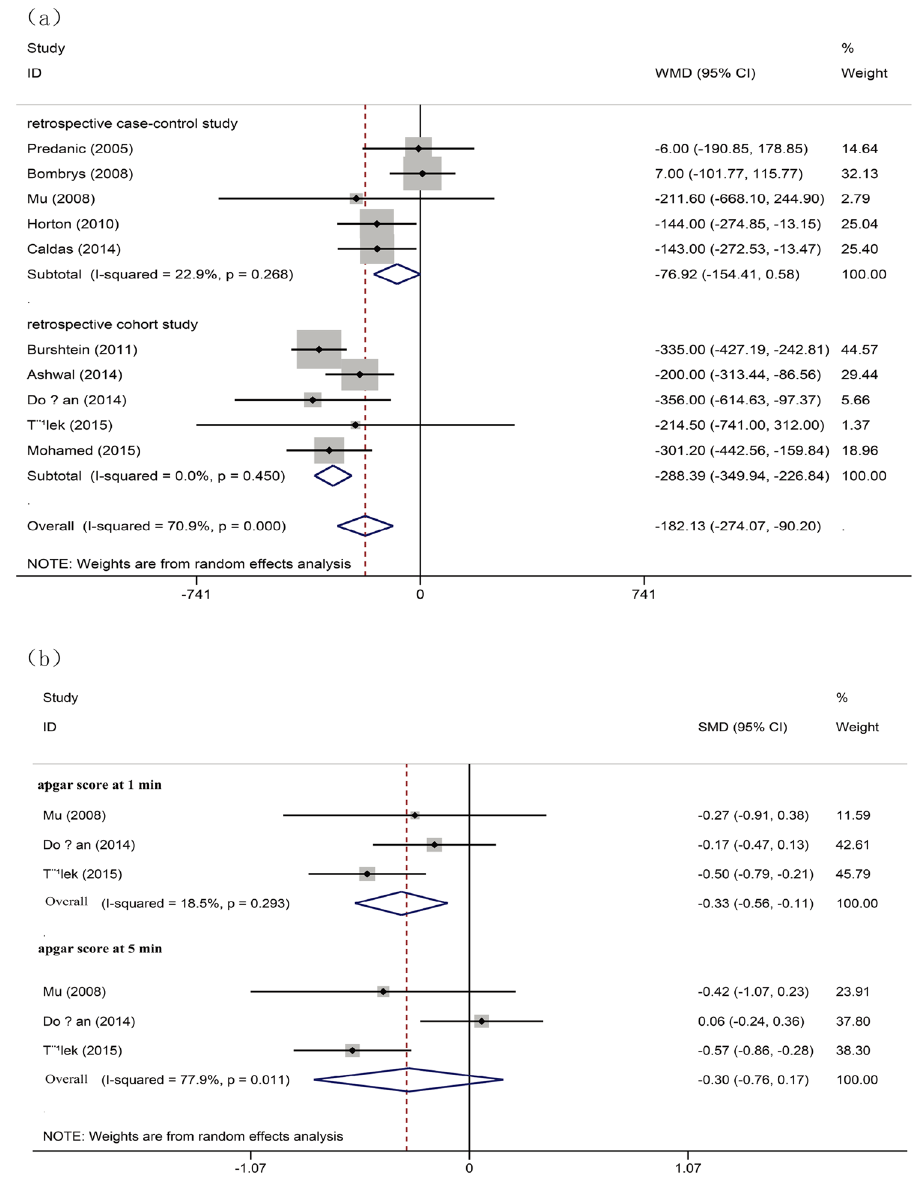
Figure 3. Forest plot of study assessing the association between iSUA and general neonatal outcomes: ( a ) association with birth weight and ( b ) association with apgar score at 1 and 5 min